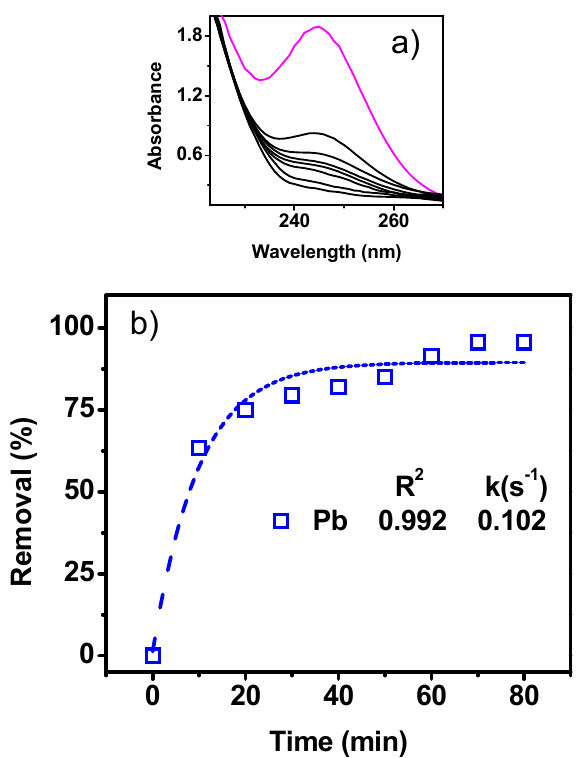
Figure 14. Removal of lead ions: ( a ) UV-Vis spectra of Pb complex: the spectra were recorded every 10 min. ( b ) Removal curves for lead.